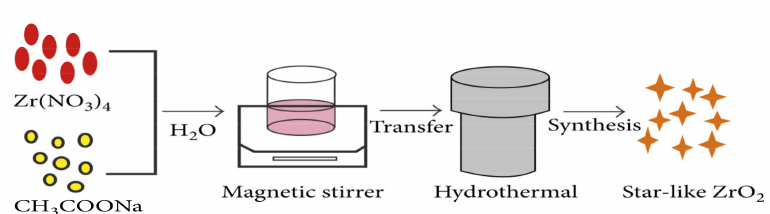
Figure 3. The procedure for ZrO 2 preparation via the hydrothermal method, copied with permission from Ref. [32], Hindawi,